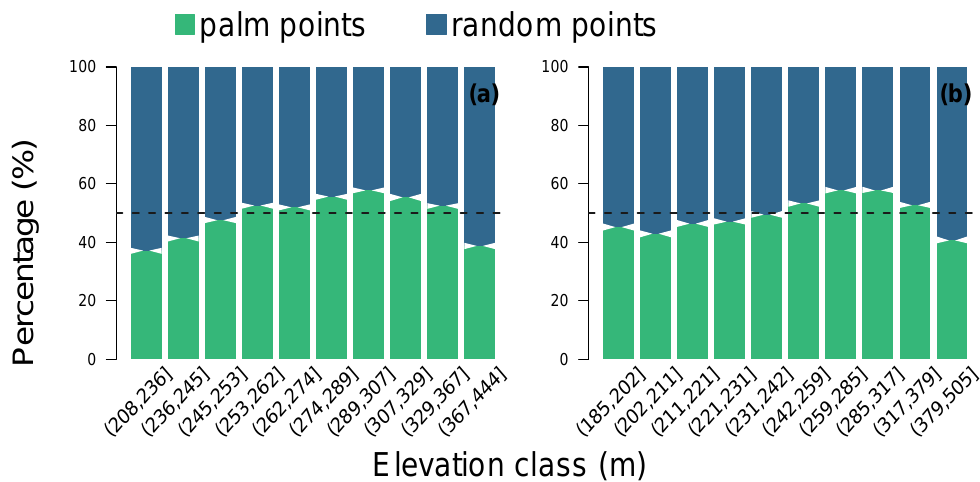
Figure 10. Comparison of the observed palm patches elevation and the elevation of same number of points sampled from a random distribution for the region 8 ( a ) N obs = 16,129; and region 9 ( b ) N obs = 15,500. For a given elevation class, if the confidence interval intersects with 50%, there is no significant difference between the distribution of palm and a random distribution for this